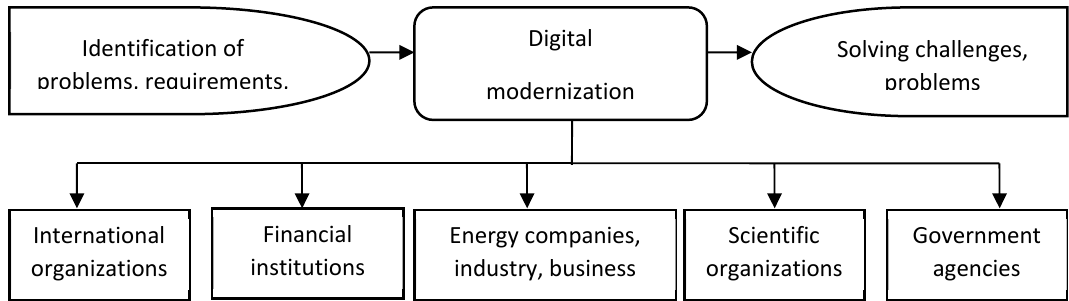
Fig. 3 : Communications of institutions in the process of digital modernization of energy systems